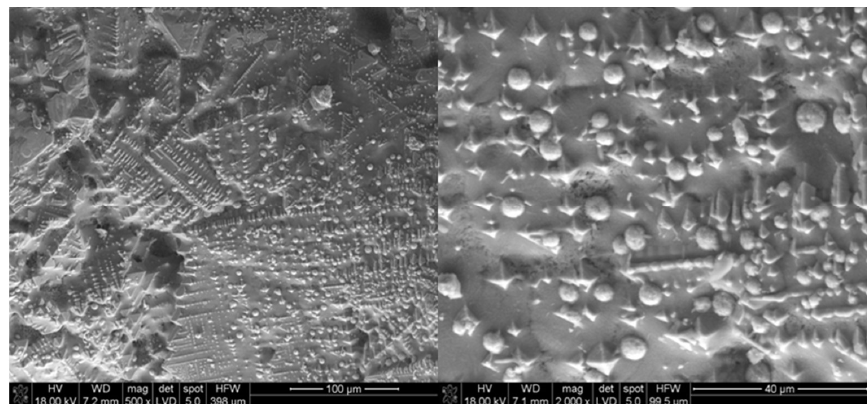
Figure 7. SEM-EDX sample identified as CuCon1.